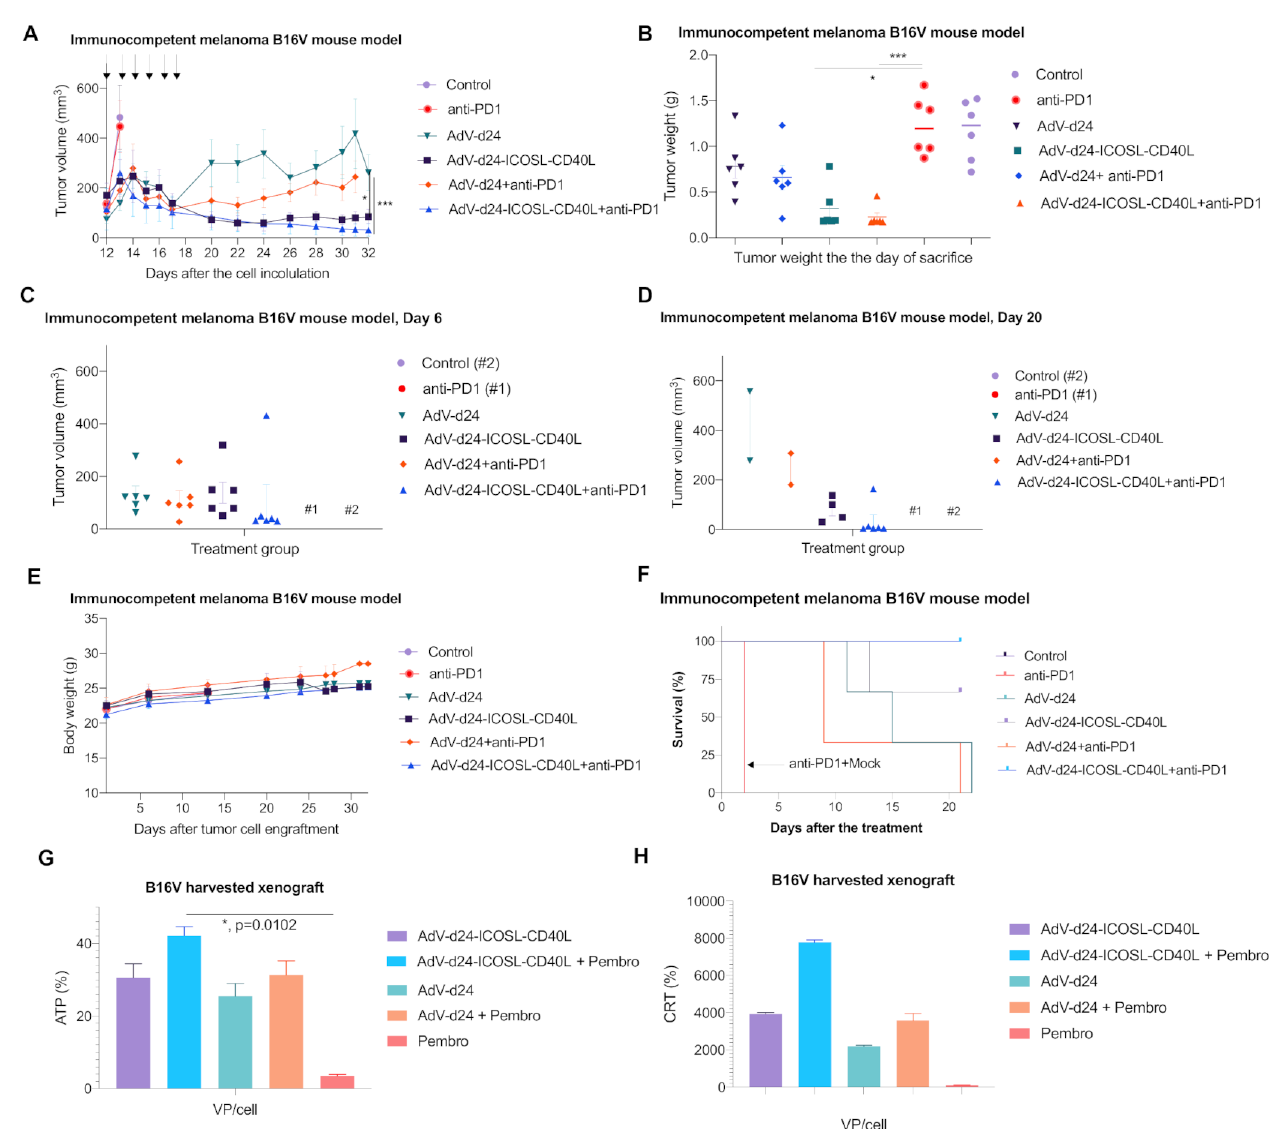
Figure 5. Antitumor efficacy of oncolytic vectors and the combination therapy with anti PD-1 antibody in murine melanoma B16V (1 × 10 6 cells/flank, one mouse had 2 tumors/6 tumors per group) xenograft immunocompetent C57BL/6 model. ( A ) Tumor volume (mm 3 ) measured through the study. The treatment was performed once per day on days 1–6. The mice were treated according to the scheme (Table 1) with viruses (i.t.) and anti PD-1 antibody (i.v.) ( B ) At the end of the study, mice were sacrificed and tumors harvested for weight assessment. ( C , D ) Tumor volume measurement on days 6 and 20. ( E ) Body weight measurements throughout the study. ( F ) Survival profile was calculated by Kaplan–Meier test. ( H